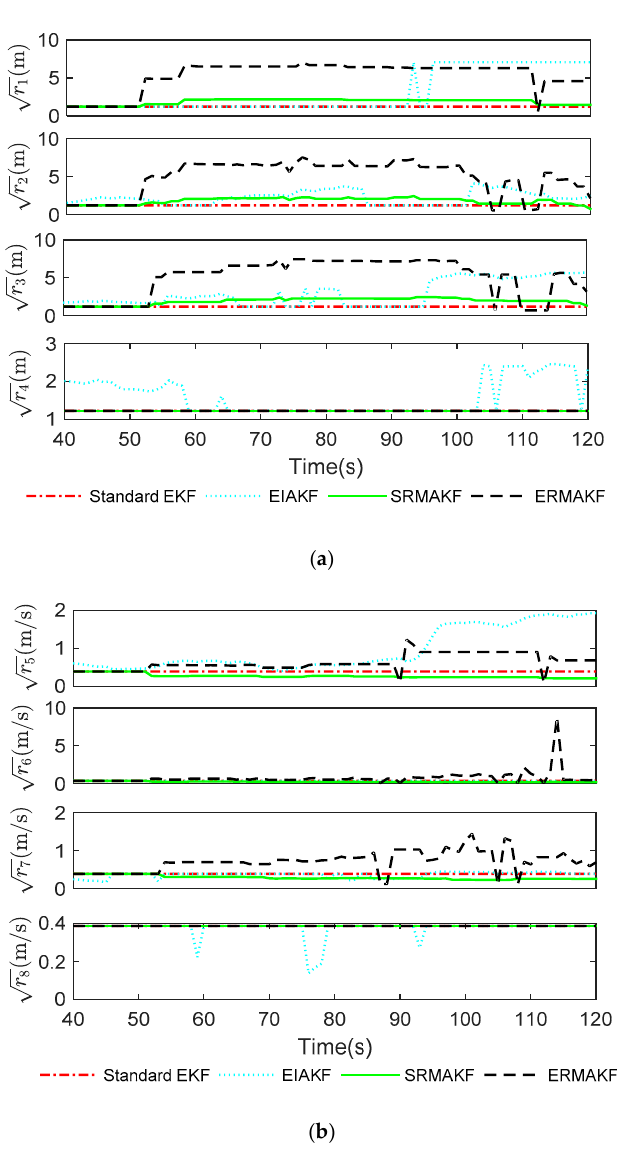
Figure 7. Estimated measurement noise standard deviations. ( a ) Estimated noise standard deviations of the pseudo-range. ( b ) Estimated noise standard deviations of the pseudo-range rate.